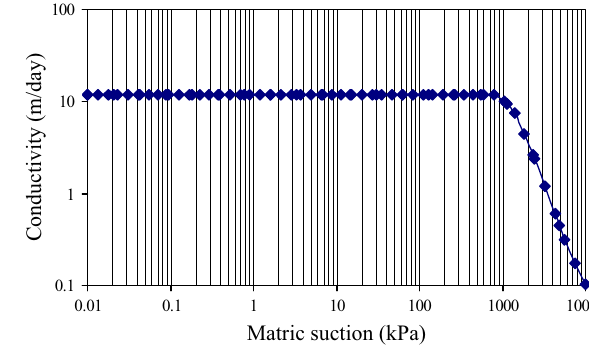
In fi ltration and collapsing stages ( elastic - plastic model )